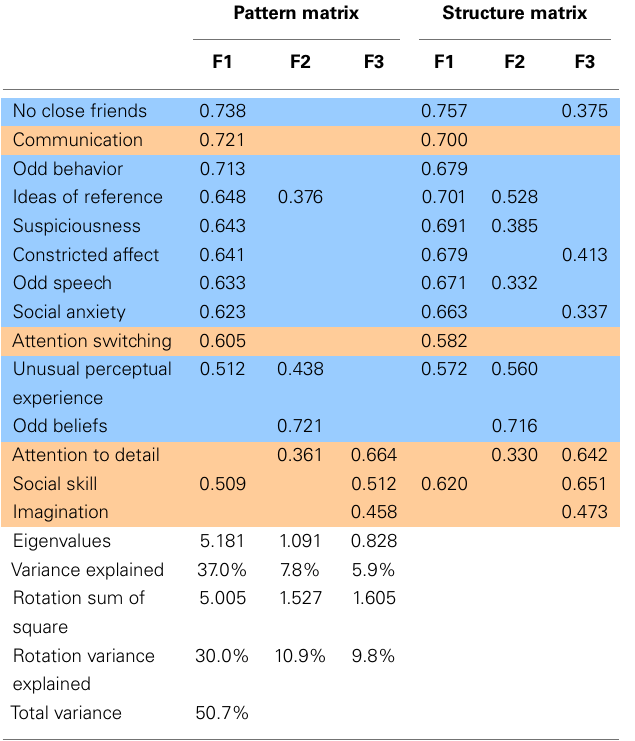
Table 4 | Factor analysis pattern and structure matrix of combinedAQ and SPQ subscales .